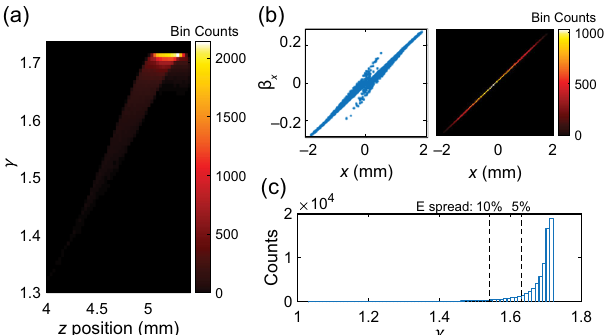
FIG. 6. (a) Longitudinal phase space after acceleration and a drift. The peak is highly localized near the maximum achievable energy. (b) Scatter and density plots of the transverse phase space after acceleration and a drift, showing the beam diverging. The beam is symmetric in x and y and thus only x - β x is shown. (c) Histogram of the electron energy distribution. The clear peak is at around γ ¼ 1 . 71 – 1 . 72 or about 365 keV, very close to the single particle prediction. The energy bins are γ ¼ 0 . 01 or roughly 5 keV. The dashed lines indicate the cutoffs for 5% and 10% energy spread from the maximum value. it is ϵ N ¼ 1 . 04 mm-mrad. These values are on par with existing photocathode values and are the expected order of magnitude for a 50 μ m radius tip.